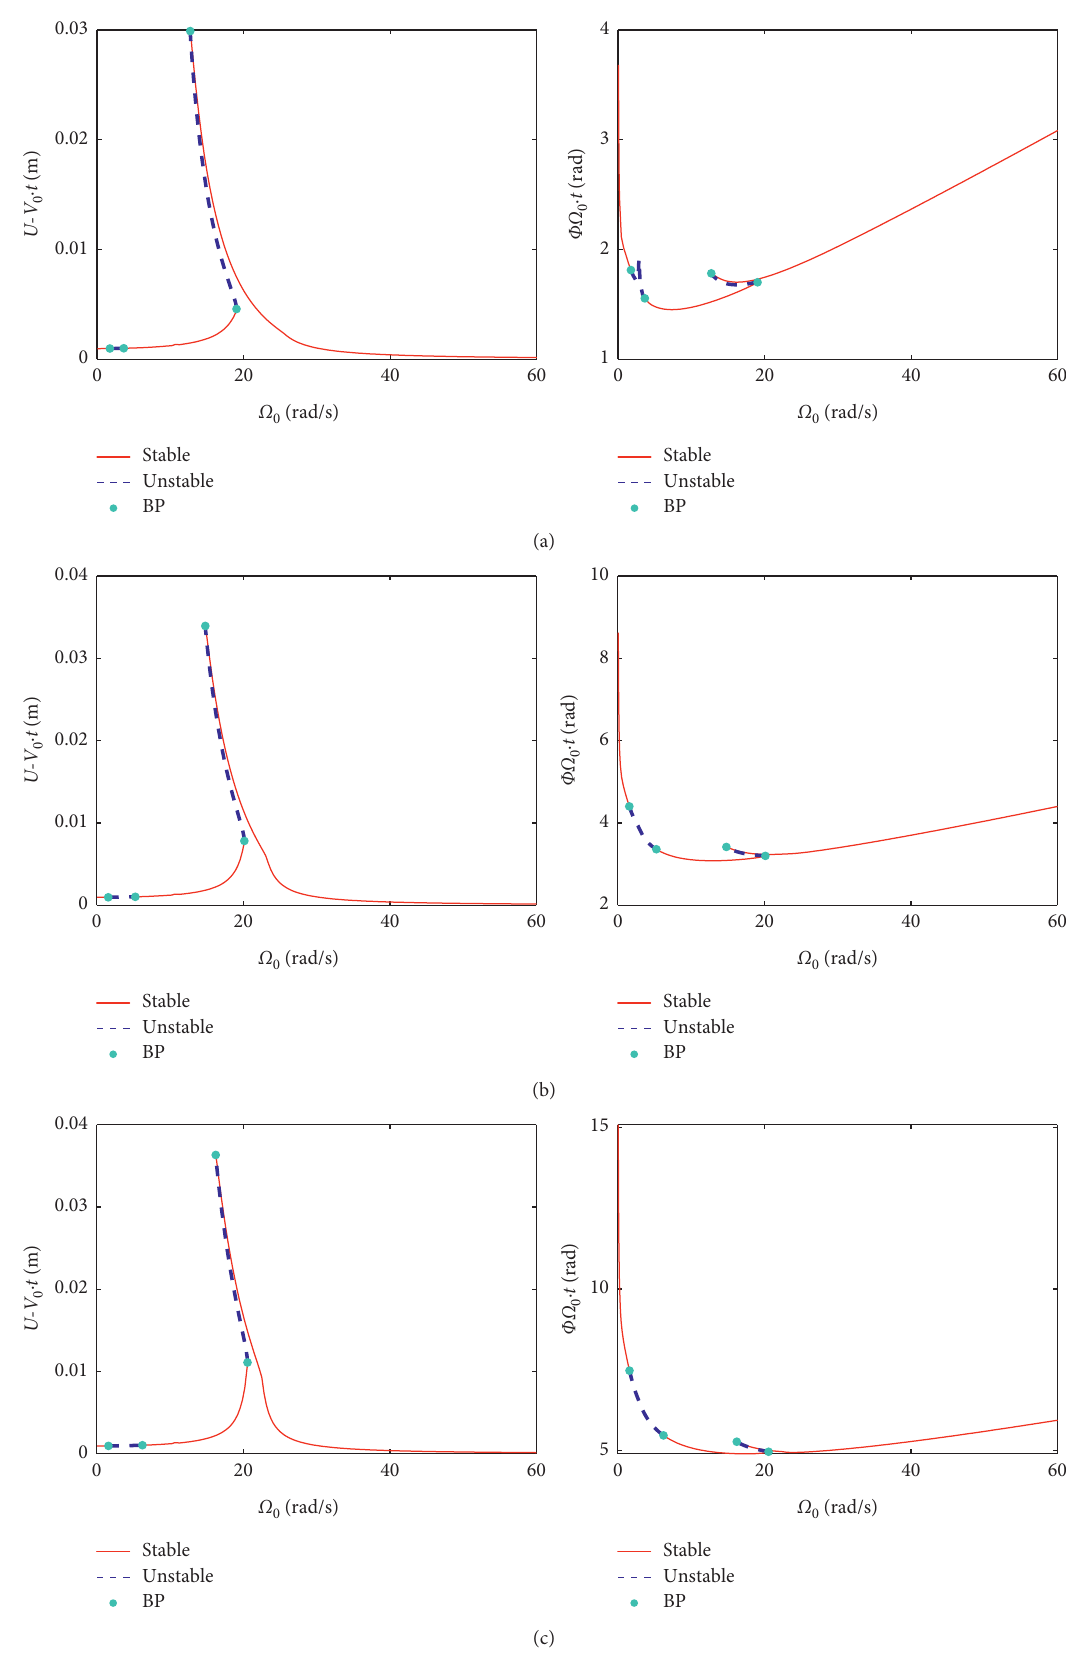
Figure 3: Amplitude-frequency curve of the system as k